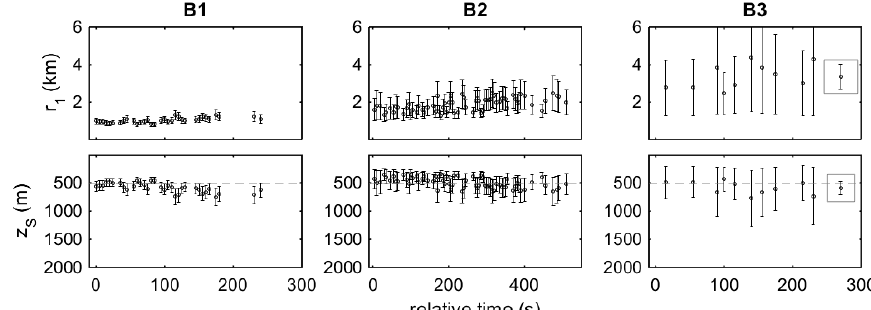
Figure 11. Localization results for source range (from front hydrophone) and source depth during stations B1–B3 of the deep-water pinger localization experiment. The error bars about the estimated means ( ◦ ) indicate the posterior RMS errors. The dashed lines represent the actual pinger depth (511 m). The framed results at station B3 corresponds to the average of individual estimates.